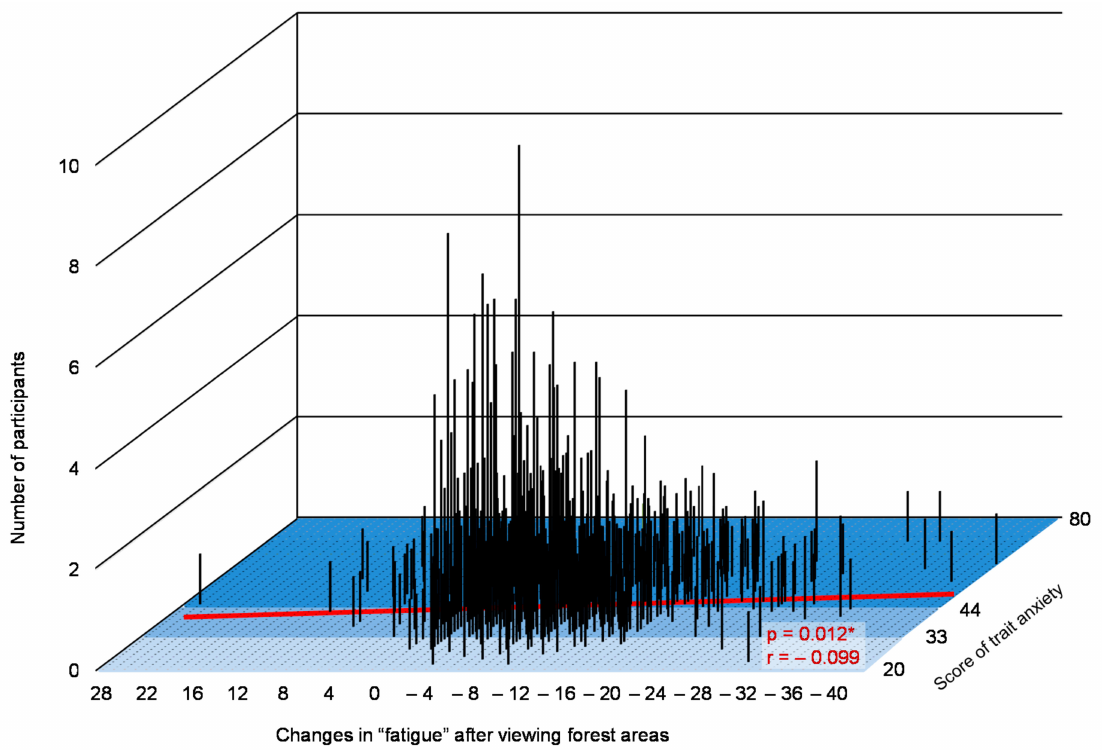
Figure 4. A graph indicating the relationship between changes in fatigue after observing forest landscapes, number of participants, and trait anxiety scores. n = 649, *: p < 0.05 decided by the Pearson’s correlation